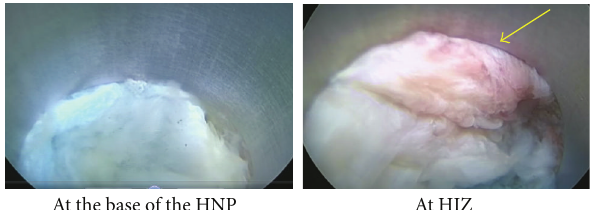
Figure 4: Endoscopic view of the disc showing the migrated white nucleus fibrosus (left panel). At the site showing the HIZ, a slightly red migrated nucleus pulposus is apparent (right panel), suggesting inflammation and/or penetration of new vessels into the mass.